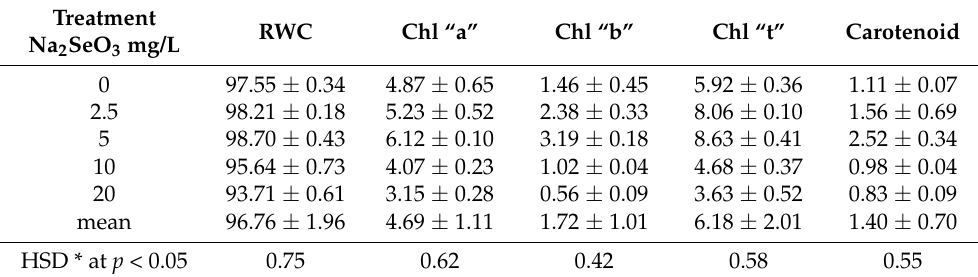
Table 2. Effect of various selenium levels (Na 2 SeO 3 ) on relative water content (RWC), chlorophyll-a. (Chl “a”, “b”), total chlorophyll (Chl “t”), and carotenoid content of quinoa plants after 30 days of selenium treatment. Number of samples 15:5 replications and 3 biological replicates.